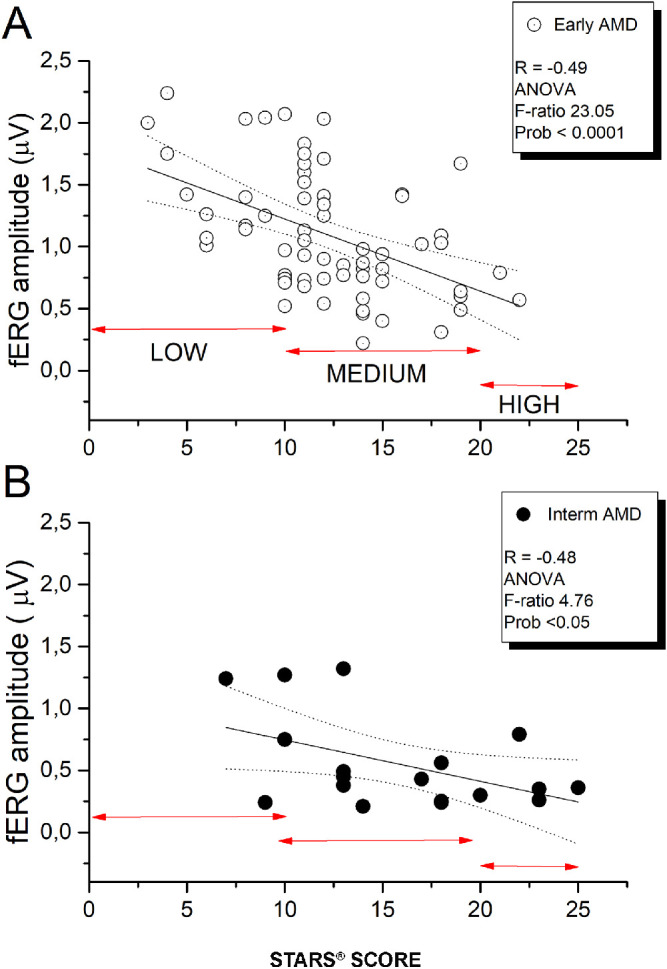
fERG amplitude plotted as a function of STARS score for patients with early AMD (A) and patients with intermediate AMD (B). In both groups, linear regression analysis reveals a significant association between the two parameters. fERG amplitude versus the STARS score: early AMD (P = 0.00008), intermediate AMD (P = 0.043). Arrows in A indicate low-, medium-, and high-risk scores. Arrows in B indicate the same score groups as in A. ANOVA, analysis of variance.